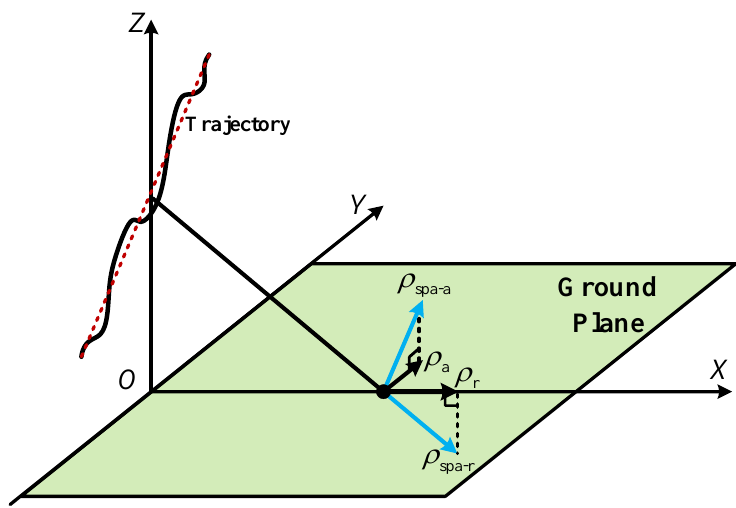
Figure 4. Directions of spatial resolution and traditional resolution.